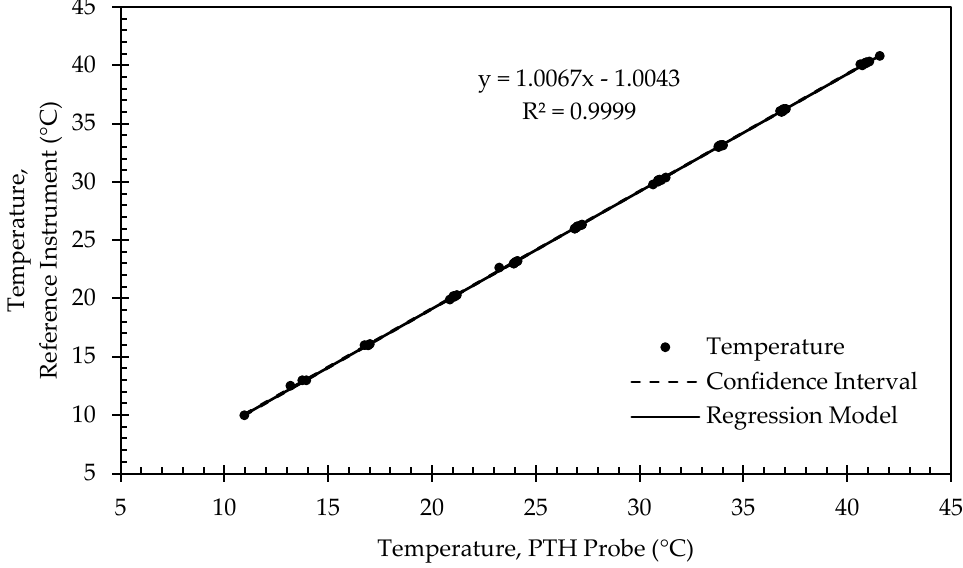
Figure 11. Regression model and corresponding confidence interval for temperature calibration data from representative PTH probe (SN: 0x0005).